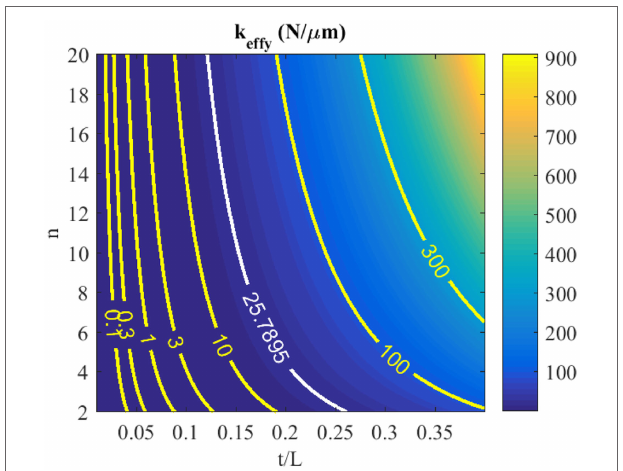
FIGURE 6 | A contour map of effective stiffness k effy plotted against t/L and number of flexures n . The contour line plotted in white is the 10% stiffness of the 7mm (cid:2) 7mm (cid:2) 10mm NOLIAC actuator as tabulated in Table 1